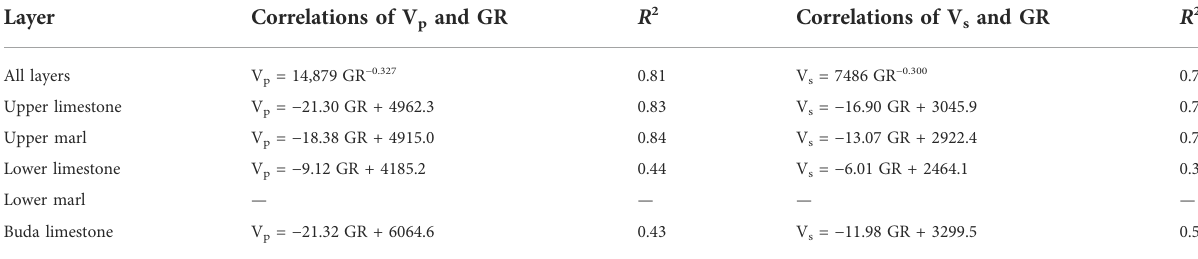
Layer Correlations of V p and GR R 2 Correlations of V s and